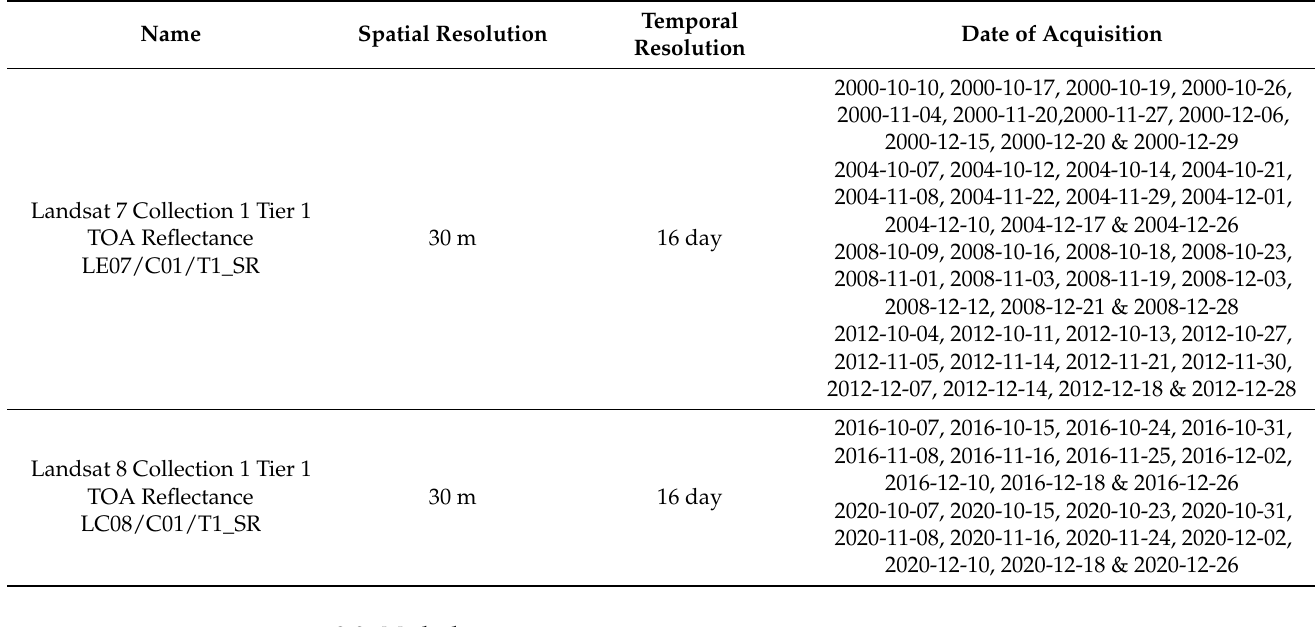
Table 1. Technical description of the Landsat imageries used in this study.